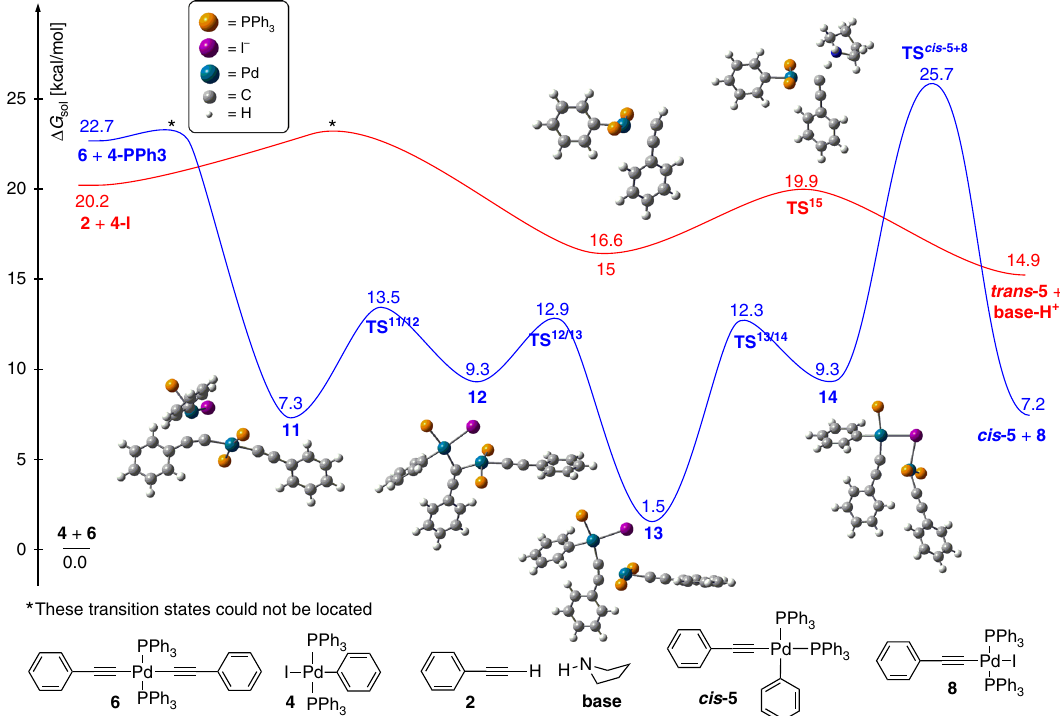
Fig. 6 DFT calculations. Computed reaction pro fi le and solution-state Gibbs free energies of stationary points for the transmetallation process, 4 + 6 → cis - 5 + 8 , and for the direct activation of phenylacetylene ( 2 ) by 4 through a monometallic